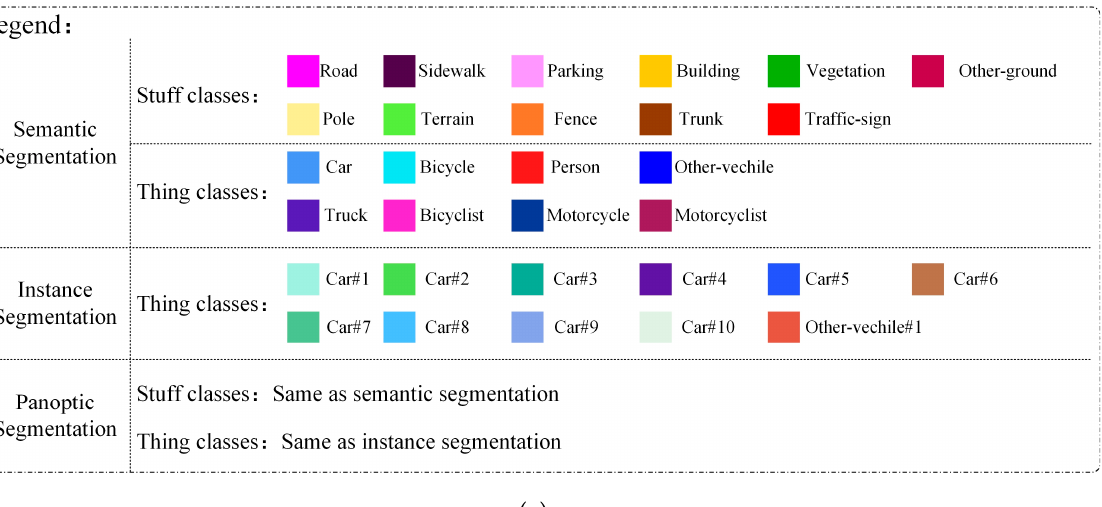
Figure 1. Visualization of typical LiDAR-based outdoor scene understanding tasks: ( a ) raw scan using viridis as a colormap, ( b ) semantic segmentation of environmental elements for category-level understanding, ( c ) instance segmentation of environmental elements in specific categories for object-level understanding, ( d ) panoptic segmentation for comprehensives understanding of the environmental element categories and specific category entities, and ( e ) legends for visualizing segmentation results; the segmentation results of the stuff classes below also follow this legend. Note that the number of entities varies in each scan, and thus the corresponding color for each entity in the thing classes is randomly generated. The color coding of thing classes in instance segmentation and panoptic segmentation do not apply to the remainder sections. ( a ) Raw Scan. ( b ) Semantic segmentation. ( c ) Instance segmentation. ( d ) Panoptic segmentation. ( e ) Legend of segmentation